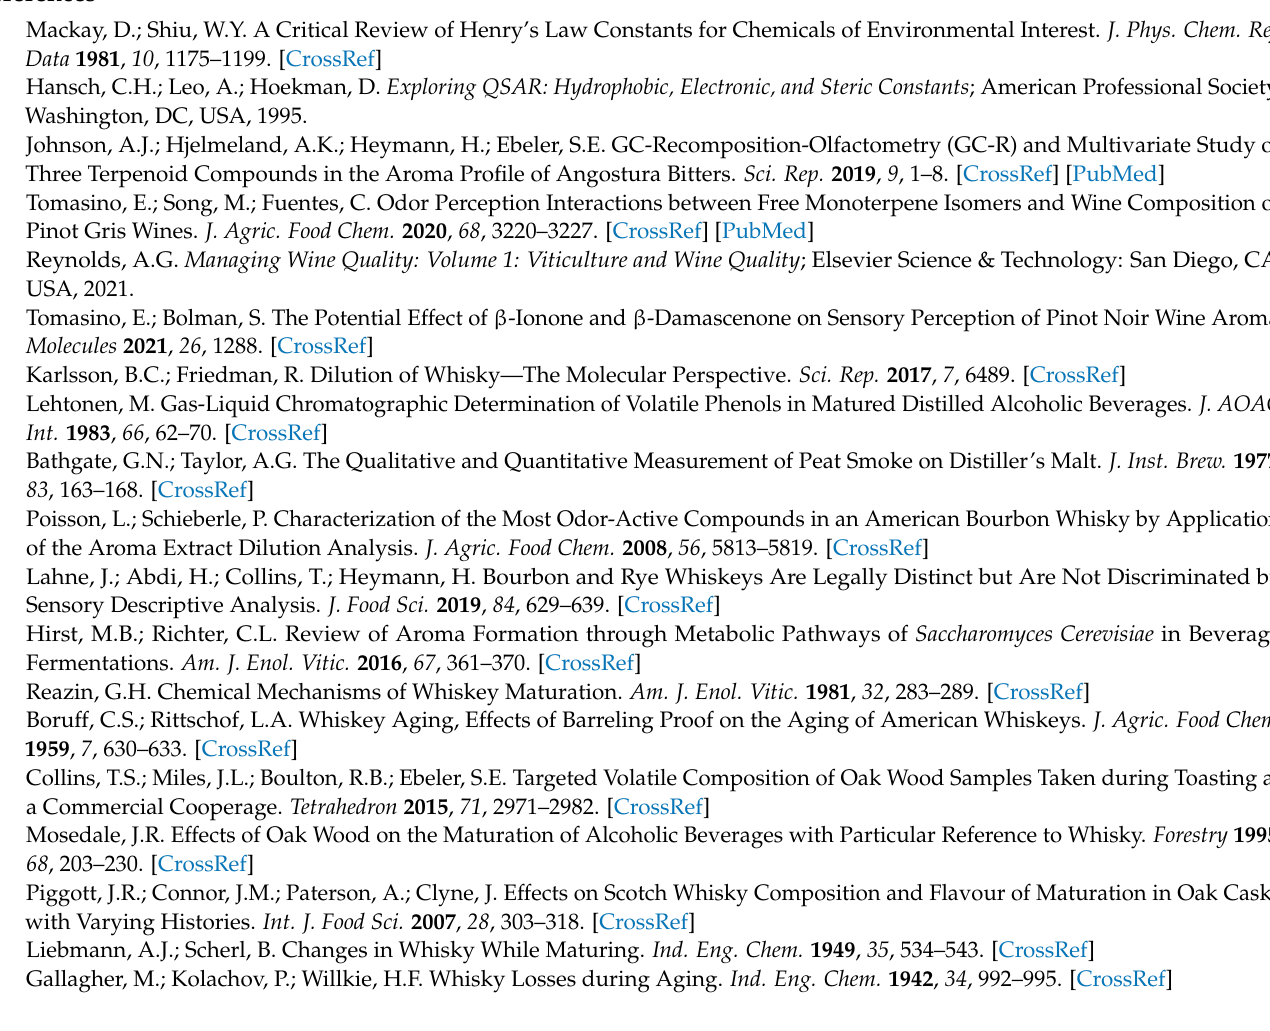
Tables S1 and S2: MFA compound classes, Table S3: Whisky samples and their abbreviations, Table S4: Cochran’s Q test results, Table S5: MANOVA F-table results for DA panel, Table S6: ANOVA F-table results for aroma descriptors, Table S7: Mixed effects model results, Table S8: Number codes for PLS (Figure 3), Figures S1–S11: Additional correlograms for compound